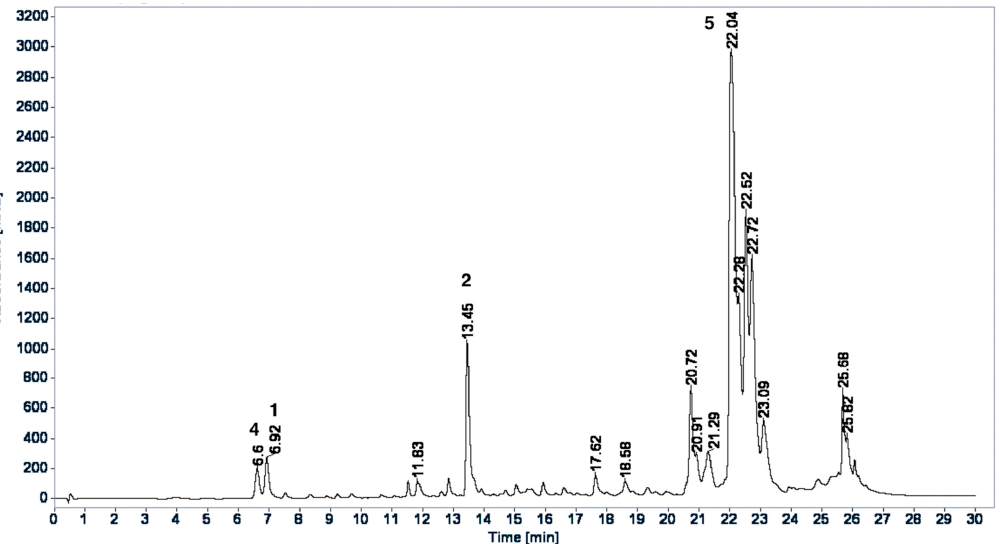
Figure 4. HPLC-DAD profile butanol extract of E. cymosum ; acquisition of λ 320 nm. Phenomenex ® Kinetex C 18 (Phenomenex Inc., Torrance, CA, USA) 100 Å (50 × 2.1 mm id., 5 µ m) reversed-phase column; the column temperature was kept at 35 ◦ C; the flow rate was 0.35 mL/min; elution was carried out with water containing 0.1% ( v / v ) formic acid and acetonitrile (MeCN), as described in the experimental